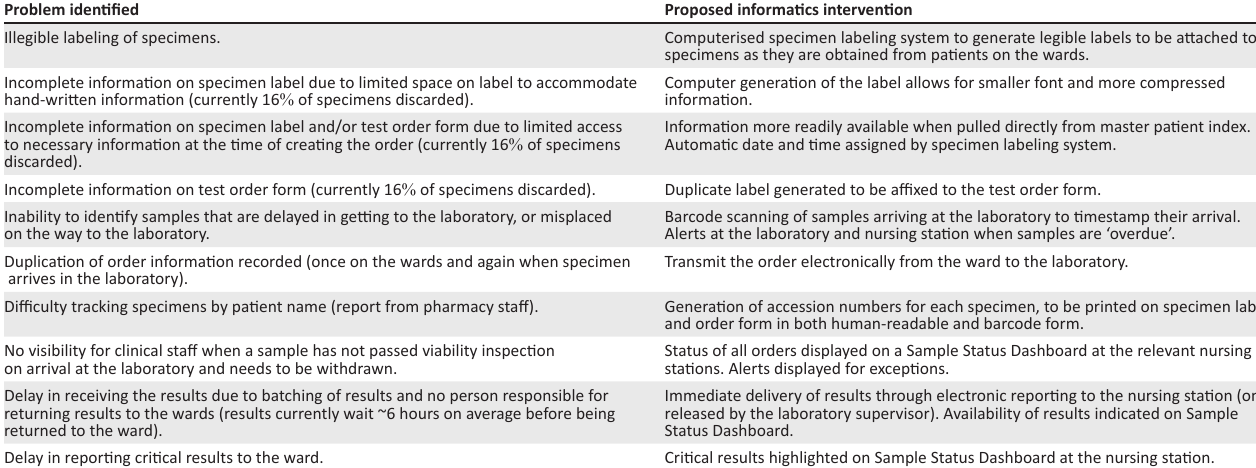
TABLE 4: Problems identified and proposed informatics solutions. Problem